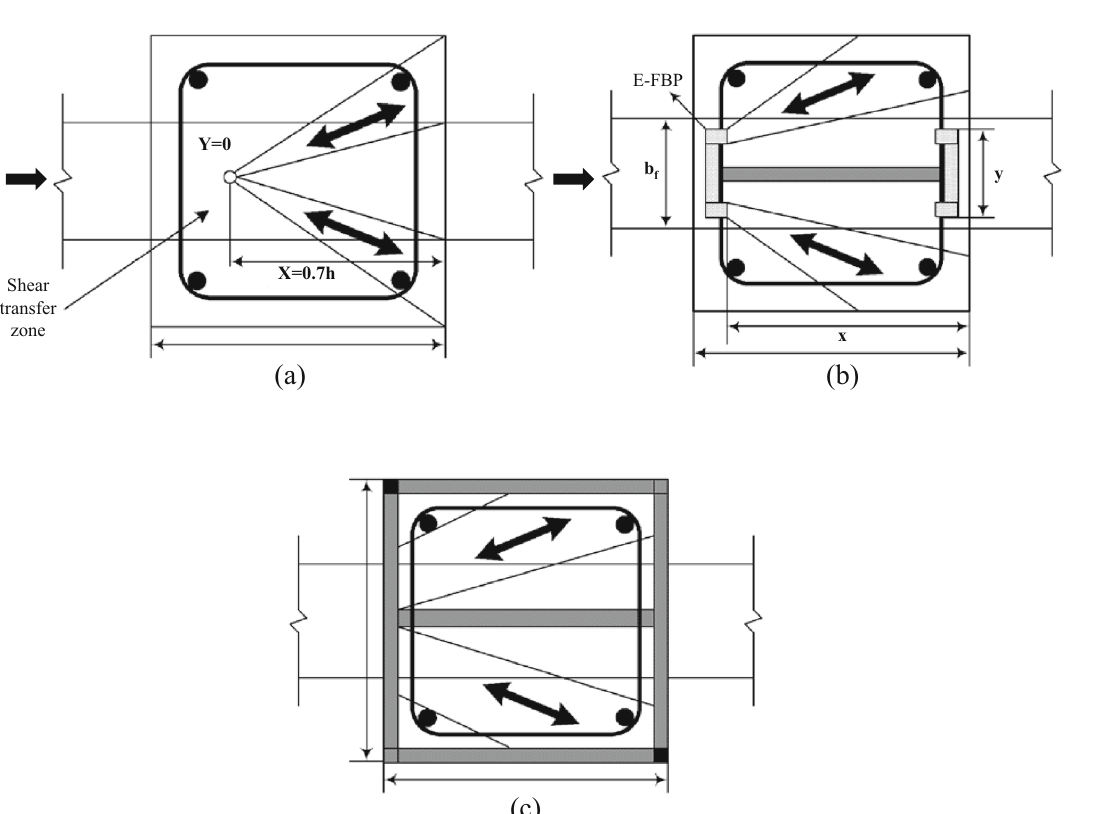
Fig. 3 Determination of stress block length x and y : a connection without a shear key, b extended face bearing plate (E-FBP) connections, and c band plate